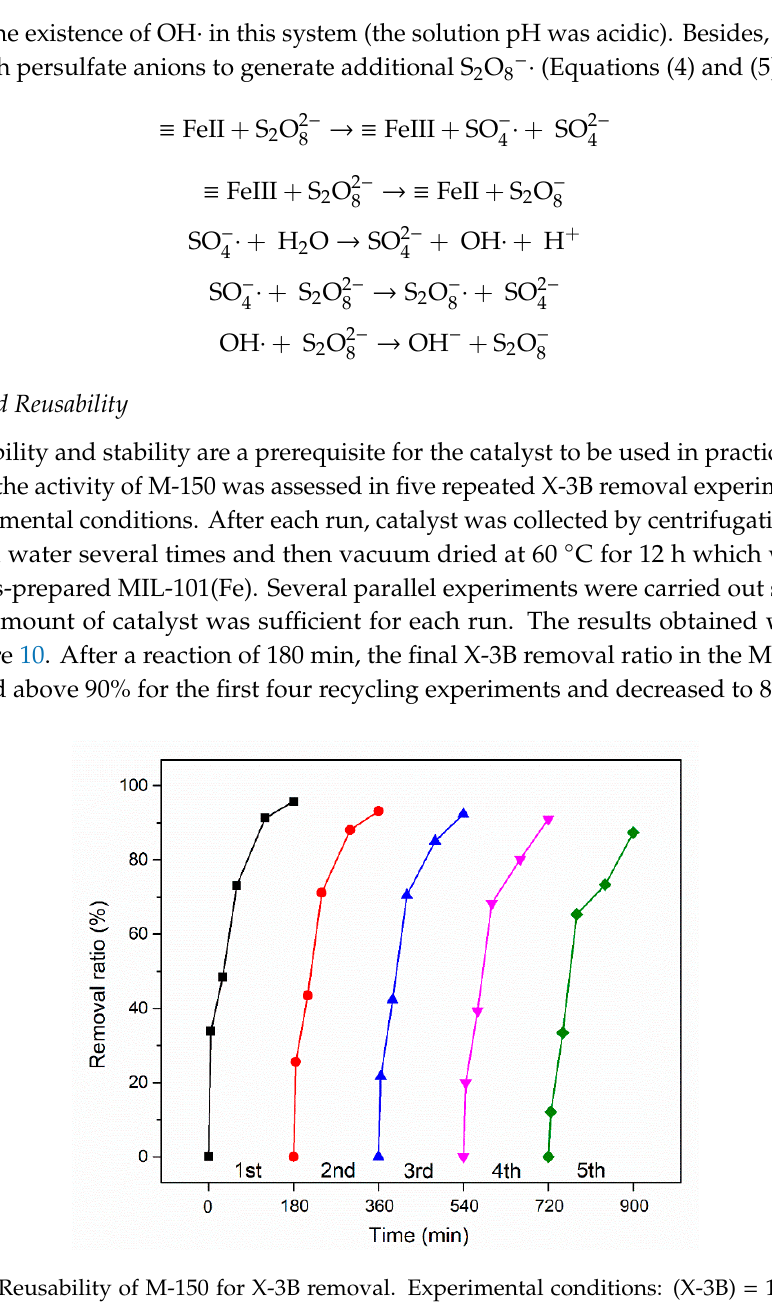
Figure 10. Reusability of M-150 for X-3B removal. Experimental conditions: (X-3B) = 100 mg L − 1 , (PS) = 15 mmol L − 1 , M-150 dosage = 0.1 g L − 1 , T = 25 ° C.